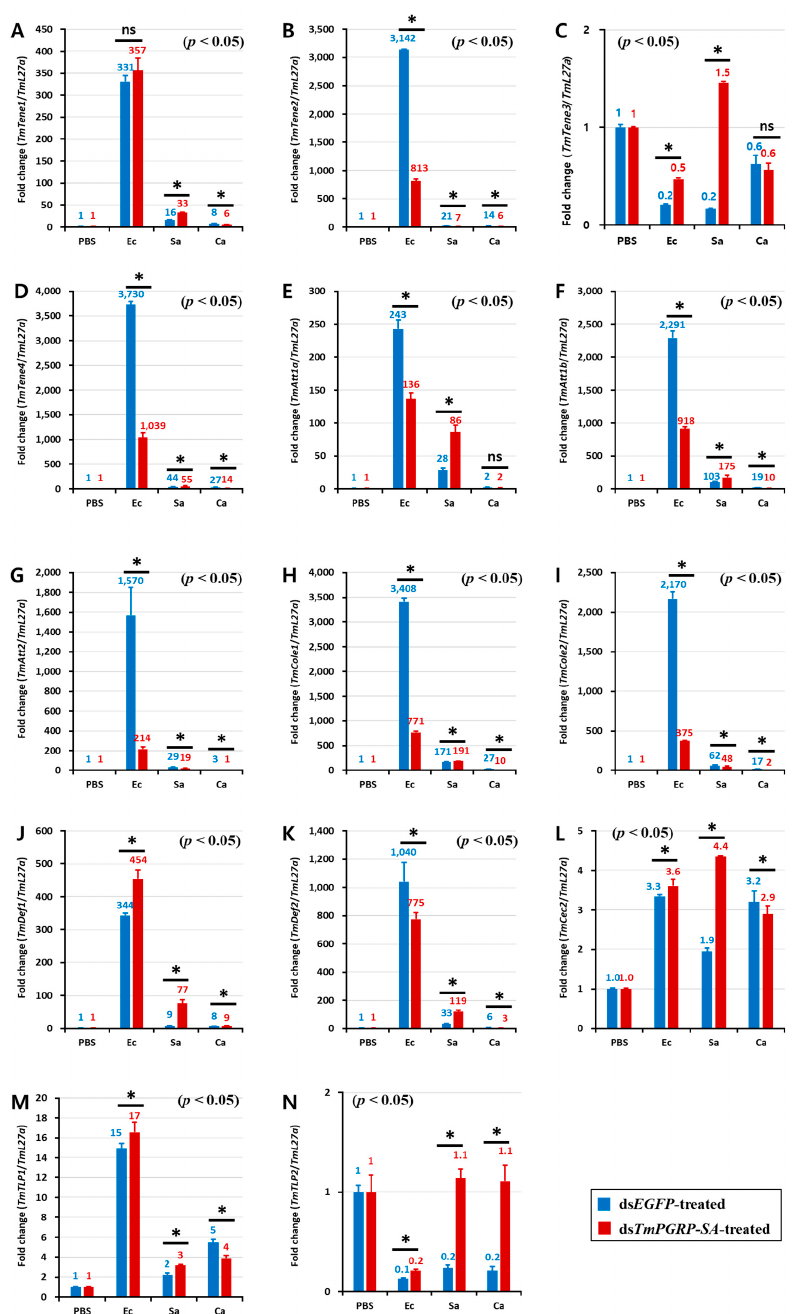
Figure 7. Expression of TmPGRP-SA is required for the induction of antimicrobial peptides in the gut. E ff ect of TmPGRP-SA reduction mediated by double-stranded RNA on infection-dependent expression of fourteen AMPs namely TmTenecin-1 ( TmTene1, A ), TmTenecin-2 ( TmTene2, B ), TmTenecin-3 ( TmTene3, C ), TmTenecin-4 ( TmTene4, D ), TmAttacin-1a ( TmAtt1a, E ), TmAttacin-1b ( TmAtt1b, F ), TmAttacin-2 ( TmAtt2, G ), TmColeptericin-1 ( TmCole1, H ), TmColeptericin-2 ( TmCole2, I ), TmDefensin-1 ( TmDef1 , J ), TmDefensin-2 ( TmDef2, K ), TmCecropin-2 ( TmCec2, L ), TmTLP-1 ( TmTLP1, M ), and TmTLP-2 ( TmTLP2, N ) in the larval gut of T. molitor against microbial challenge with E. coli (Ec), S. aureus (Sa), and C. albicans (Ca) were quantified relative to L27a at 24 h post-infection. ‘*’ indicates significant di ff erence between ds TmPGRP-SA and ds EGFP -treated group ( p < 0.05); ns = not